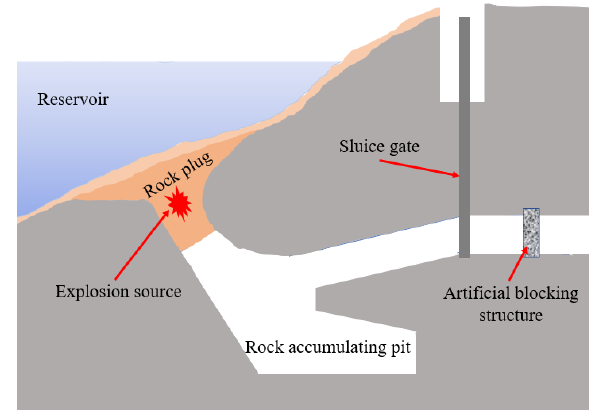
Figure 1. Schematic diagram of rock-plug blasting .